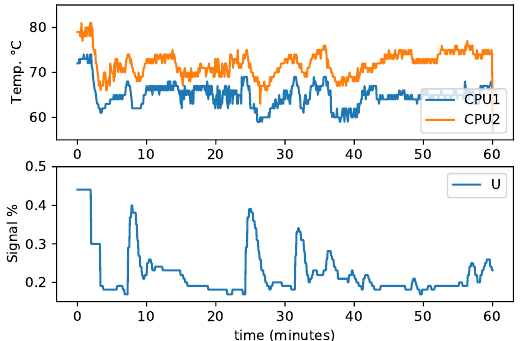
Figure 11. Results for control scenario (a) CPU focused control, which shows temperatures below threshold ( upper panel) and control signal ( lower ).